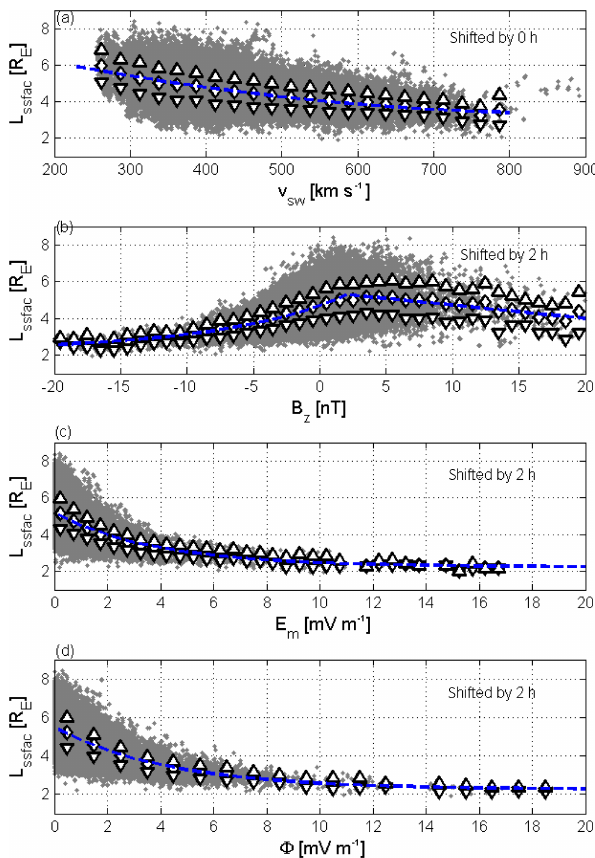
Figure 5. Dependence of the SSFAC index on the (a) solar wind speed, (b) B z IMF south GSM component, (c) merging electric field, and (d) coupling parameter ϕ